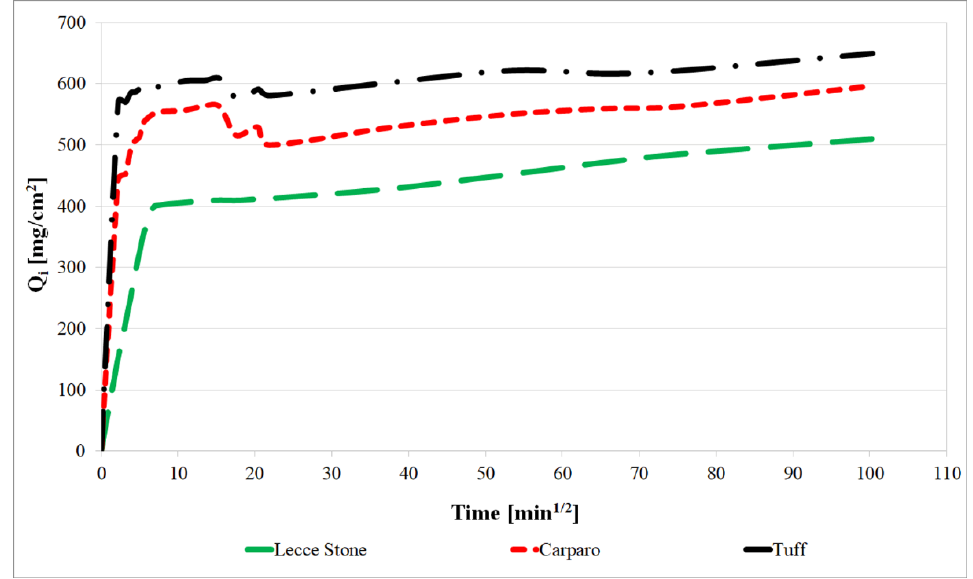
Figure 1. Development of capillary rising coefficient of the three materials.